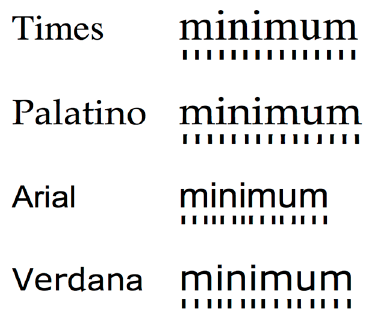
Figure 1. The horizontal periodicity in the letter strokes for the word minimum printed in Times, Palatino, Arial and Verdana. The font size has been chosen to equate the x-height. The pattern beneath each word is that formed by the central part of the letter strokes.